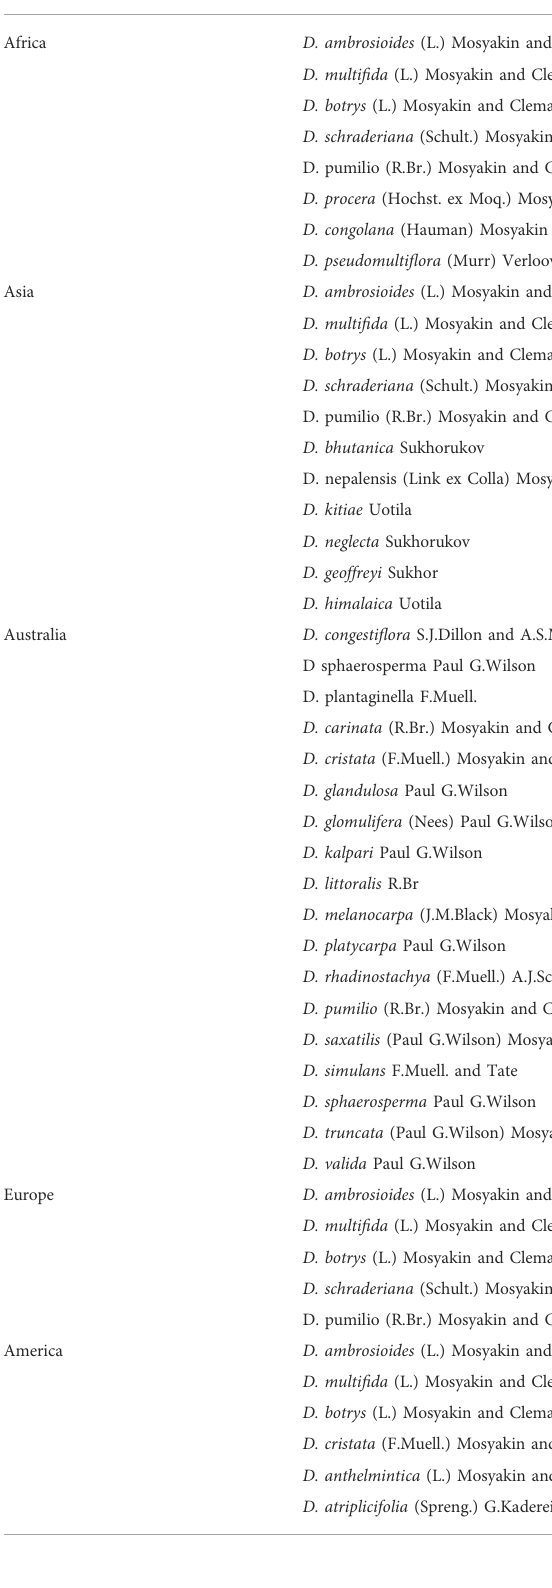
TABLE 1 Geographical distribution of some common Dysphania Spp. Continent Species